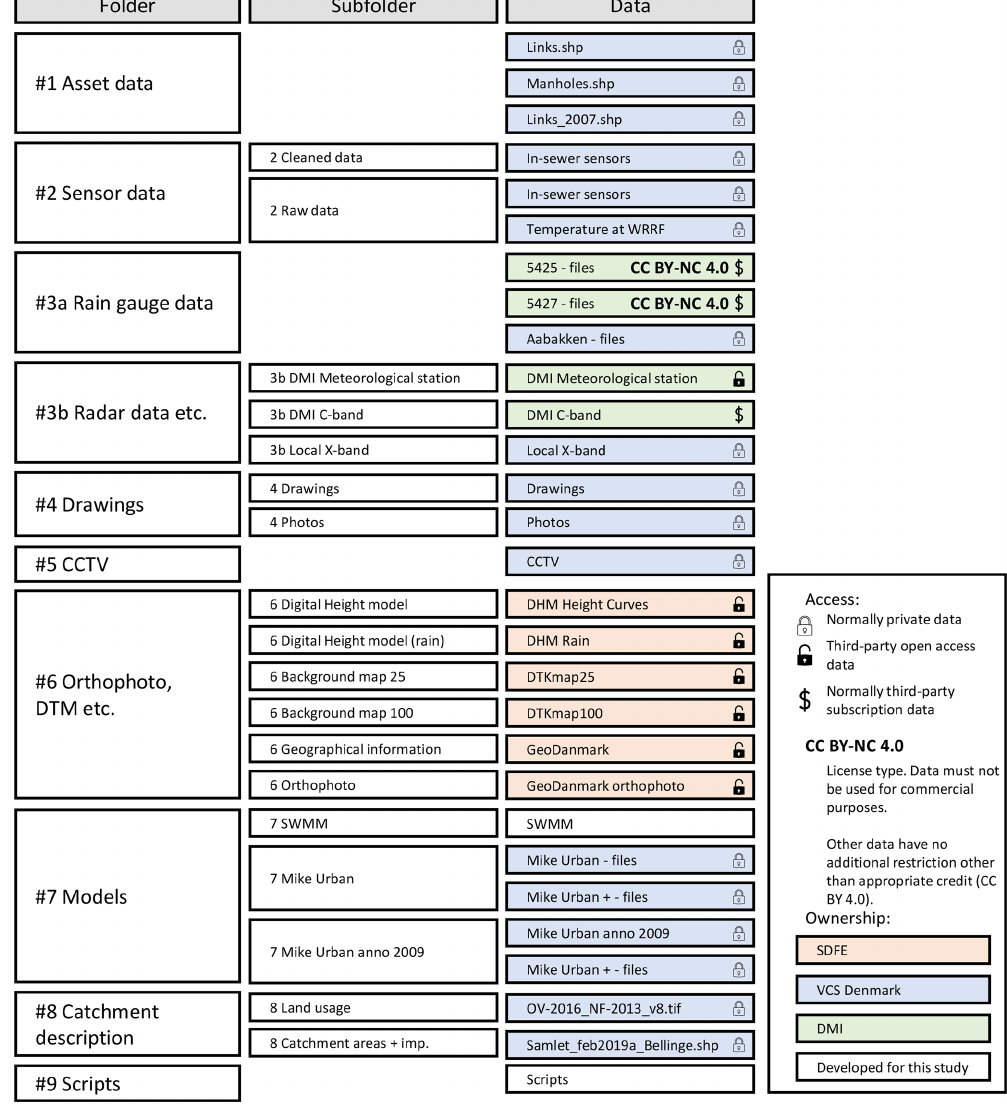
Figure 13. Overview of the items in the data repository folders and their subfolders, with an indication of the ownership of the specific data and how these data sources are normally accessed. The sensor and rain data in Fig. 7 can be found in the folders “#2 Sensor data”, “#3a Rain gauge data” and “#3b Radar